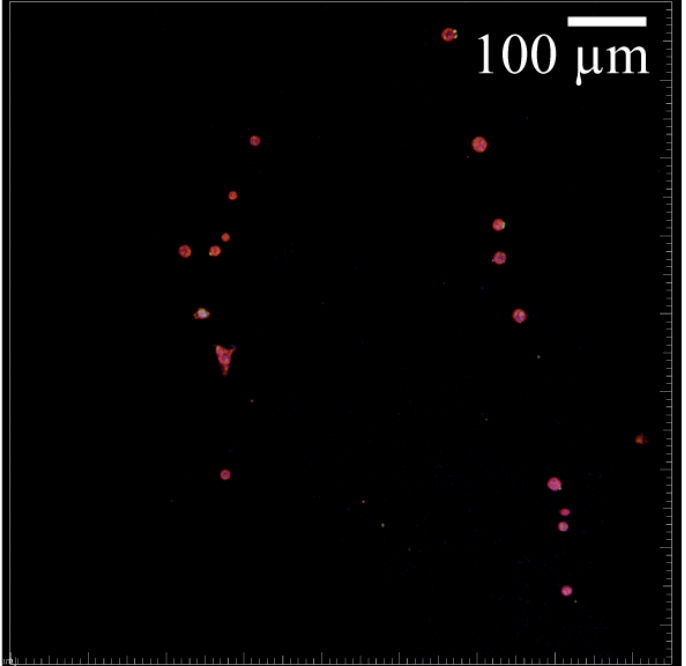
Figure 11. HEKa cells seeded on PCL scaffolds (stained image merge of KRT1 (green), KRT5 (red), filaggrin (purple), and DAPI (blue)) showing cell attachment and alignment along the scaffold fi- bers.